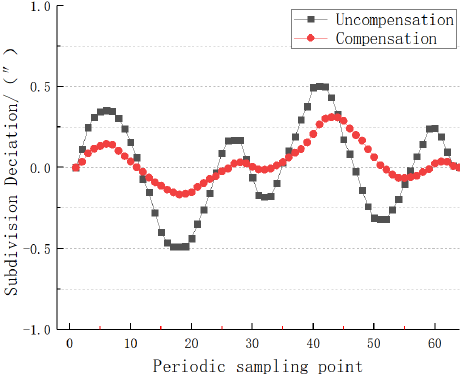
Figure 18. Comparison before and after dynamic subdivision error compensation.